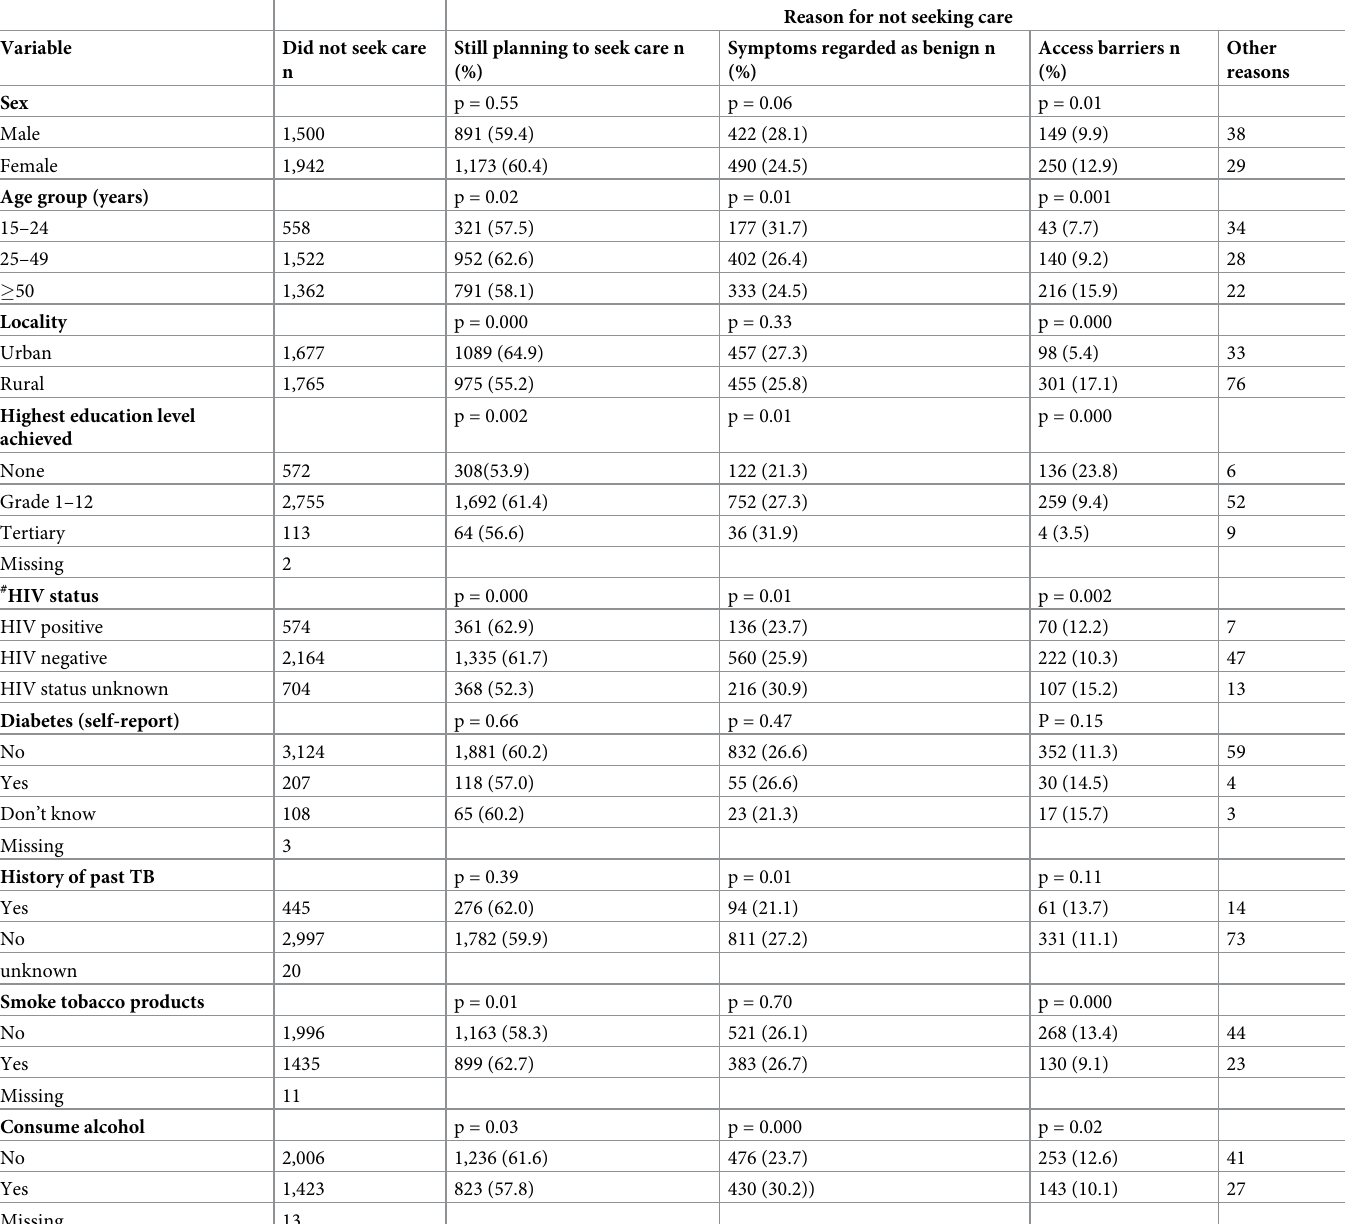
Table 1. Reasons for not seeking care for TB symptoms, N =